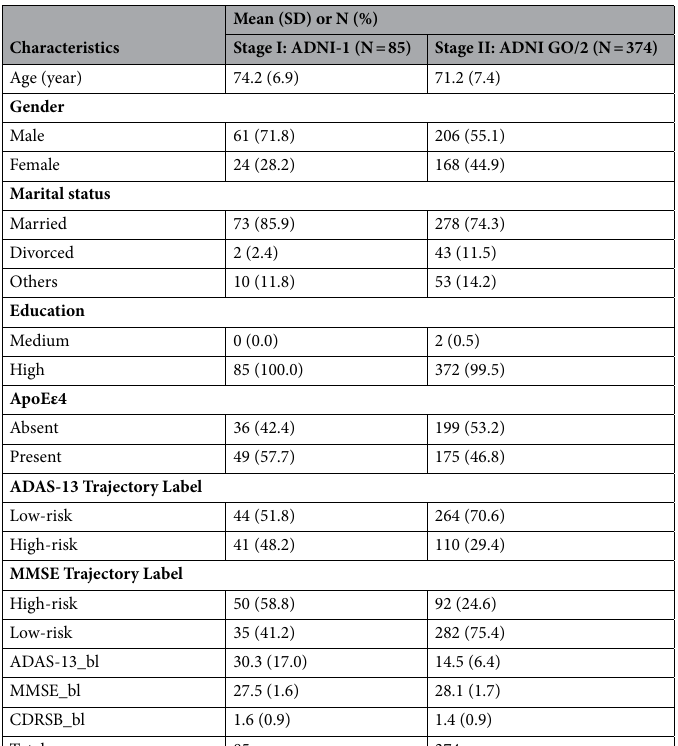
Table 1. Baseline characteristics of subjects in two stages. ADAS-13, Alzheimer Disease Assessment Scale Cognitive 13 items; MMSE, mini mental state examination; ADAS-13_bl, Alzheimer Disease Assessment Scale Cognitive 13 items at Baseline; MMSE_bl, mini mental state examination at Baseline; CDRSB_bl, Clinical Dementia Rating Sum of Boxes at Baseline; SD, standard